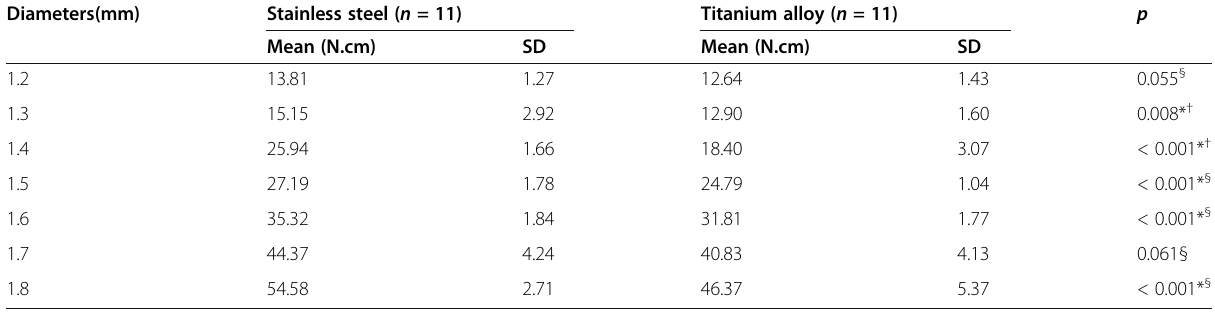
Table 1 Comparison of fracture torque between SS-MIs ( n = 77) and TA-MIs ( n = 77)